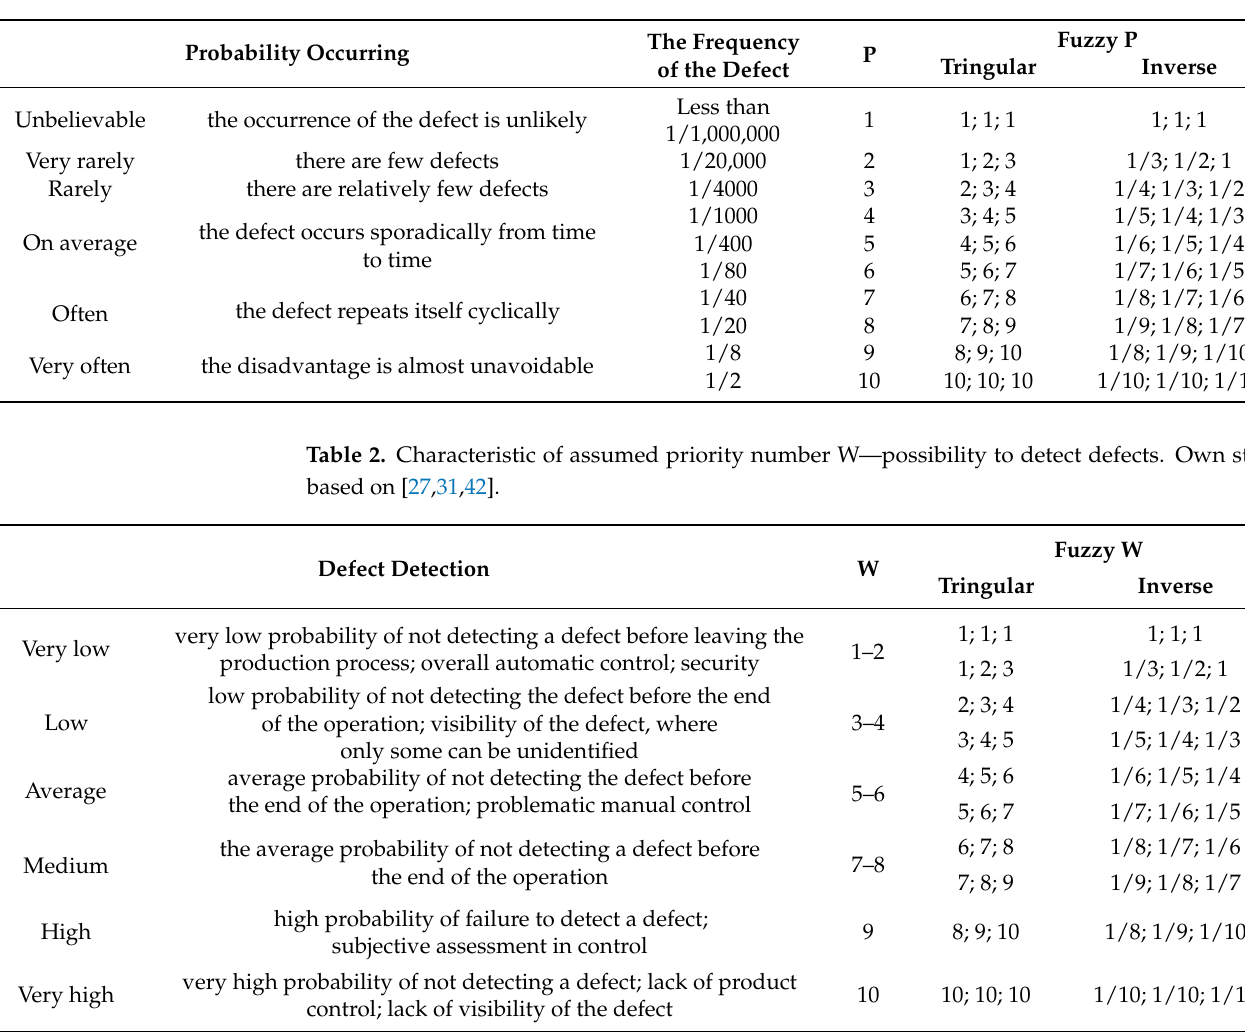
Table 1. Characteristic of assumed priority number P—probability occurring defect of process. Own study based on [27,31,42].